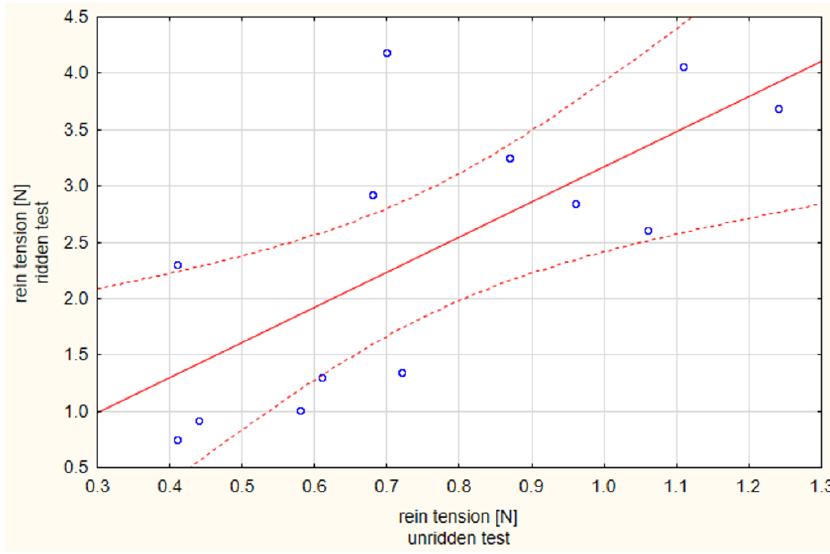
Figure 5. Correlation between the rein tension in the unridden and ridden state; correlation coefficient r = 0.702, p < 0.05; a positive linear relation between the rein tensions in the unridden and ridden state is shown in the scatterplot, circles represent results of individual horses; the dotted lines indicate the 95% confidence interval.